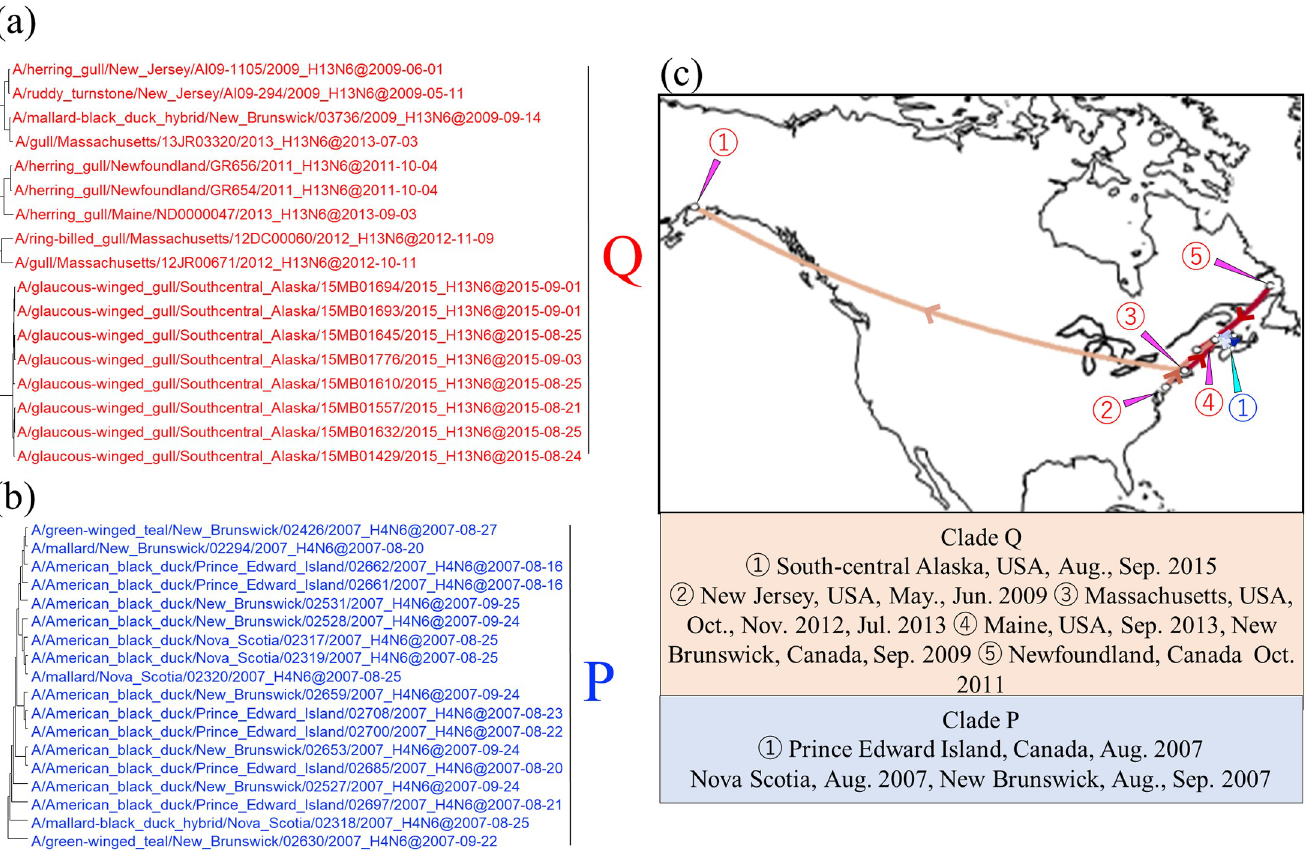
Fig 6. Detail of maximum clade credibility (MCC) phylogenetic trees of N6 NA genes in clades Q and P and visualized location-annotated MCC trees for selected clades on the world map (c). Clades Q and P are red type and blue type, respectively, in each tree (a and b), and colored type lines in (c) correspond to those of the clade. Lines with Bayes factors of 3.0 or more are shown in the map, and a deeper color means a higher Bayes factor.